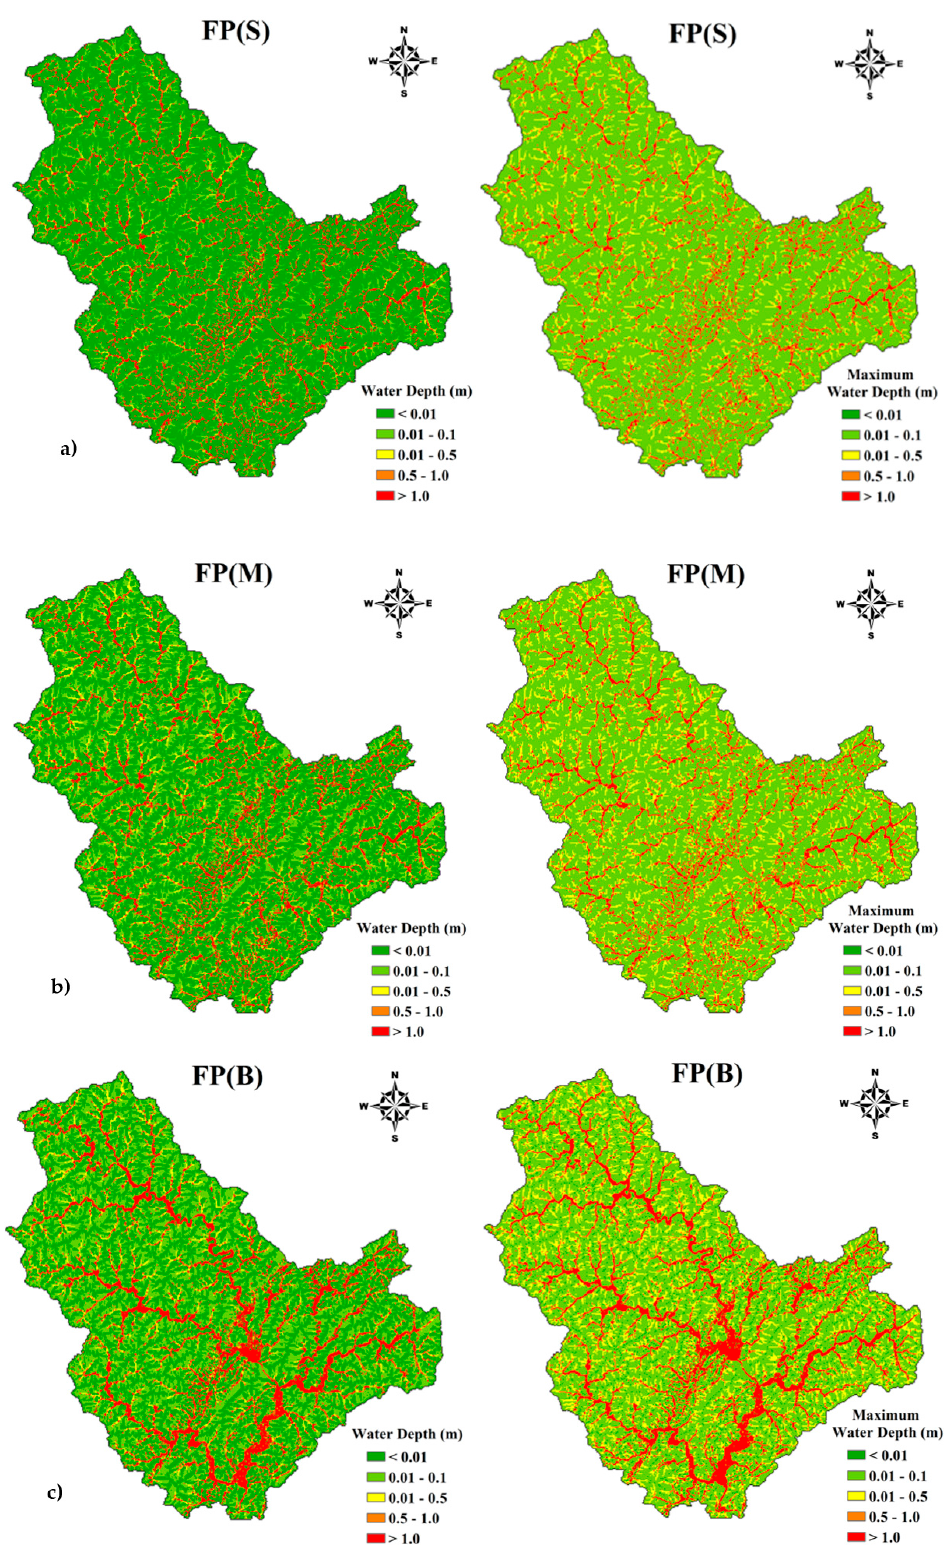
Figure 6. ( a ) FP(S): Snapshot of inundated extent at the peak moment (left) and map of maximum water depth (right); ( b ) FP(M): Snapshot of inundated extent at the peak moment (left) and map of maximum water depth (right); ( c ) FP(B): Snapshot of inundated extent at the peak moment (left) and map of maximum water depth (right).